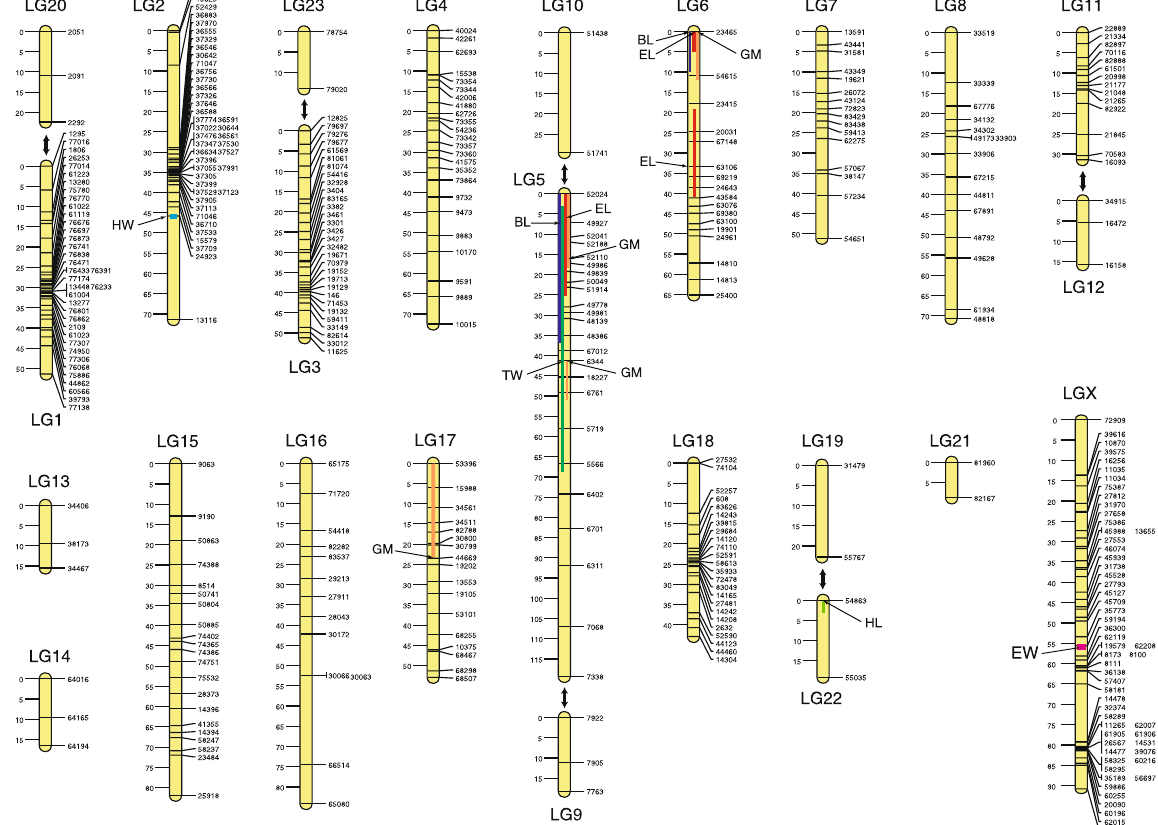
Figure 4. Linkage map of Carabus japonicus showing the locations (peak and range) of the body dimension quantitative trait loci (QTLs). Two-way arrows connect linkage groups probably located on the same